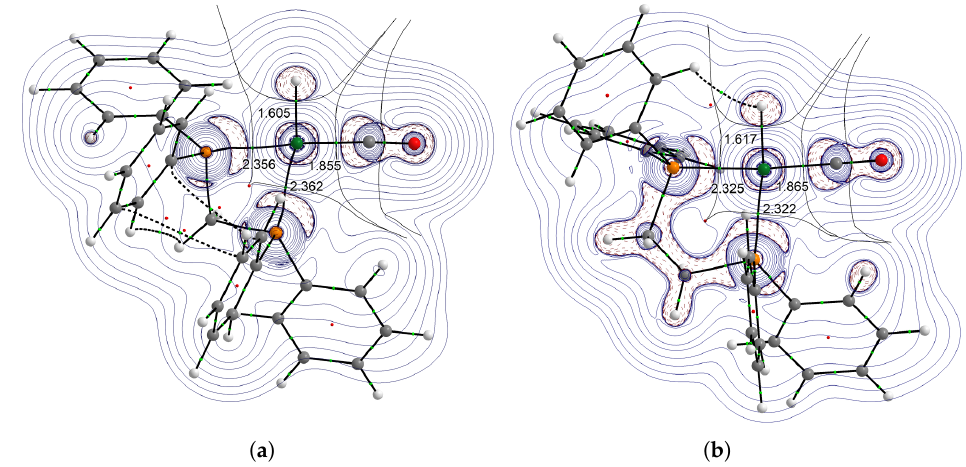
Figure 4. Laplacian ( ∇ 2 ρ ( r ) ) of the electron density of complexes HRh(dppm)(CO) ( a ) and HRh(dppe) (CO) ( b ). Charge concentration regions ( ∇ 2 ρ ( r ) < 0) are designated with dashed